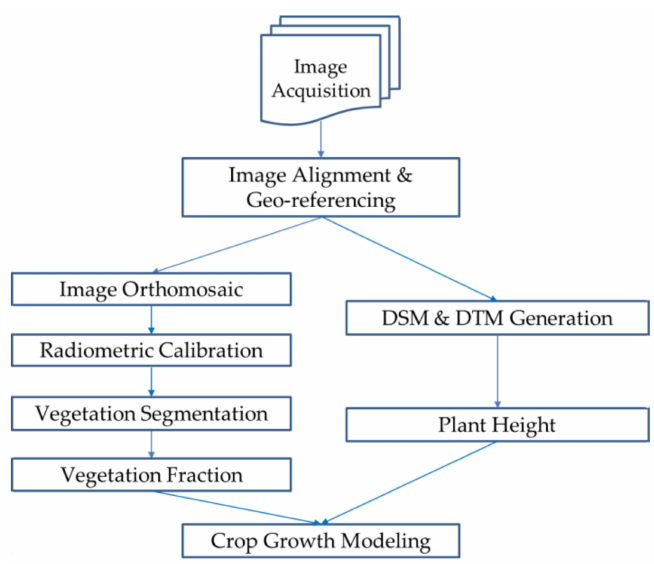
Figure 2. Flow chart of image processing and crop growth modeling procedures for building regression models based on vegetation fraction and plant